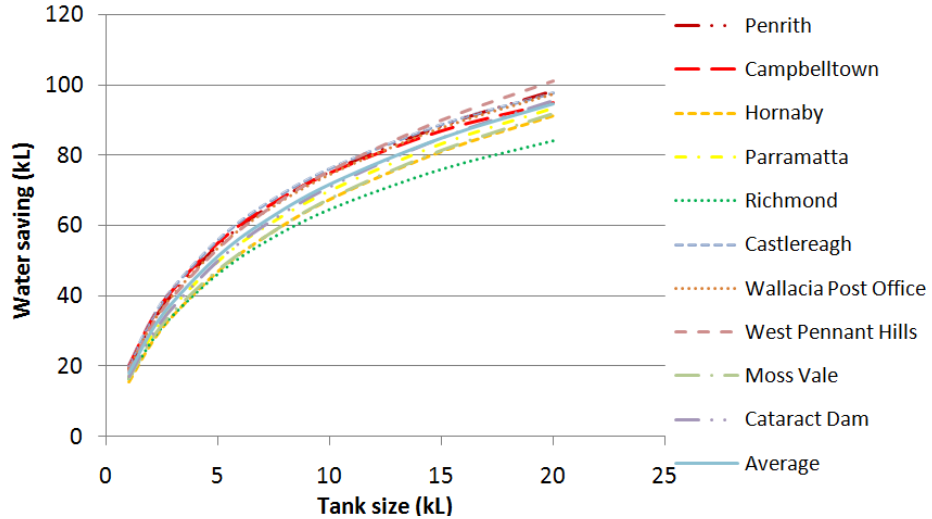
Figure 7. Water savings from a RWHS for irrigation use (considering the daily rainfall data of all the years on